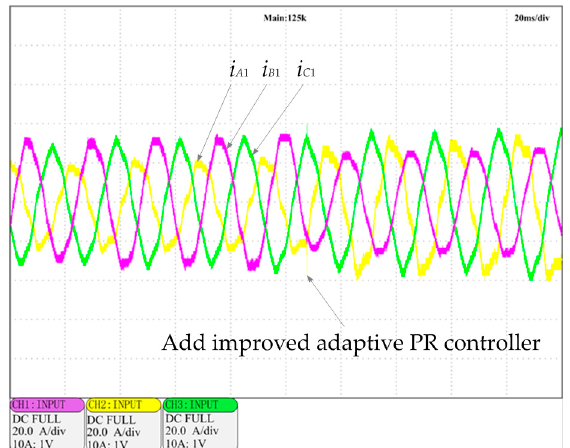
Figure 17. The current waveform of DRPMSM.